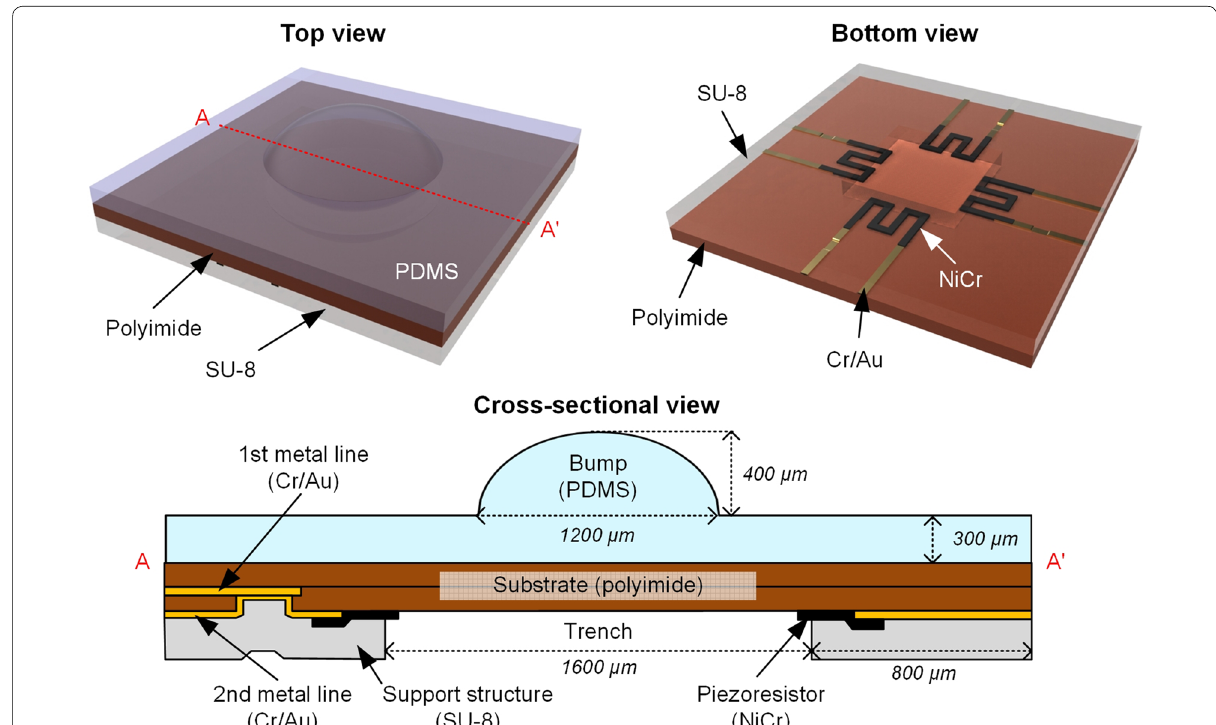
Fig. 1 Schematics of the polymer‑based flexible tactile sensor with integrated multiple piezoresistors. The main structure is comprised of flexible and biocompatible materials including PDMS, PI, and SU‑8. The patterned NiCr and double‑layered Cr/Au lines serve as piezoresistor and electrode,